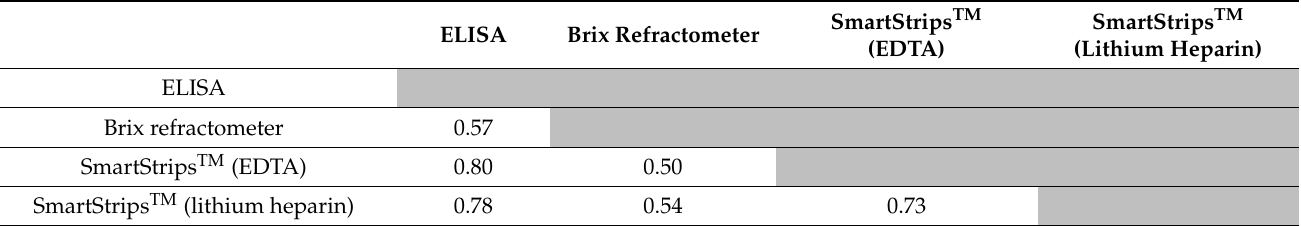
Table 4. Matrix (lower part of the diagonal) displaying weighted kappa statistics between the different methods (ELISA, Brix refractometer, quick test (SmartStrips TM ) with EDTA or lithium heparin anticoagulant). SmartStrips ELISA Brix Refractometer